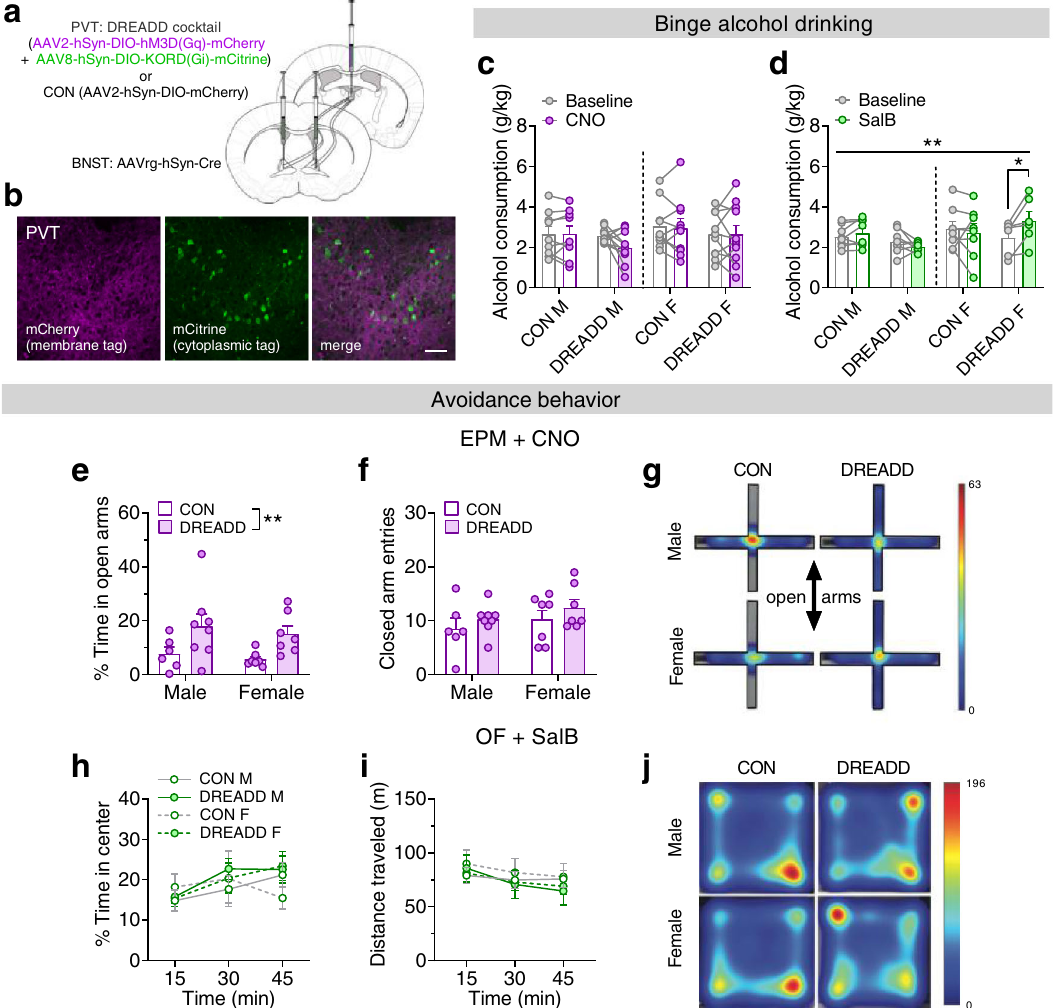
Fig. 5 The PVT BNST projection sex-dependently regulates binge alcohol drinking and avoidance behavior. a Multiplexed chemogenetic approach for PVT BNST neurons. b Representative PVT image showing coexpression of the Gq-DREADD (mCherry) and Gi-KORD (mCitrine) in PVT BNST neurons. Scale bar = 50 μ M. (Images were acquired for all mice except those used for slice electrophysiology recordings.) c – d Alcohol consumption during vehicle baseline vs. Day 4 ligand administration. c Clozapine n-Oxide (CNO; 5 mg/kg, i.p.; Gq-DREADD activation). 3xRM-ANOVA: no effects of sex, DREADD, CNO, or any interactions ( P s > 0.15; N ’ s = 9 CON M, 11 DREADD M, 10 CON F, 11 DREADD F). d Salvinorin B (SalB; 17 mg/kg, s.c.; Gi-KORD activation). 3xRM-ANOVA: sex × DREADD× SalB interaction ( F 1,26 = 8.76, ** P = 0.007) and no main effects and no interactions ( P s > 0.05); post hoc two-tailed paired t -tests with Holm-Sidak corrections for effect of SalB: DREADD females ( t 26 = 3.08, * P = 0.019), all others ( P s > 0.65). N ’ s = 8 CON M, 8 DREADD M, 8 CON F, 6 DREADD F, with 0 – 3 mice/group excluded for below-criteria baseline drinking. e – g Effects of CNO on the elevated plus maze (EPM). N ’ s = 6 CON M, 8 DREADD M, 7 CON F, 7 DREADD F. e Percent time spent on the open arms. 2xANOVA: main effect of DREADD ( F 1,24 =